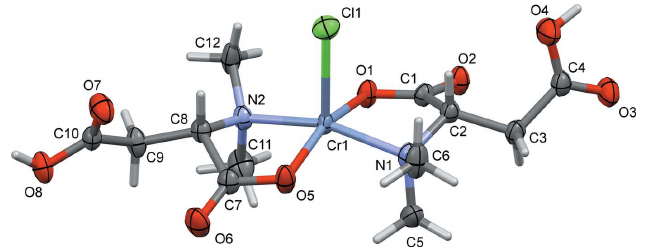
Figure 1 The molecular structure of the title complex anion, with the atom labelling. Displacement ellipsoids are drawn at the 30% probability level. For clarity, the dimethylammonium counter-ion and the water molecule of crystallization have been omitted.